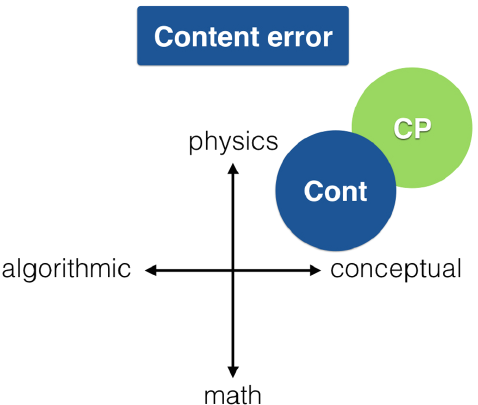
FIG. 4. Content error: Content error (Cont). The student is in CP appropriately, but is using inappropriate or insufficient